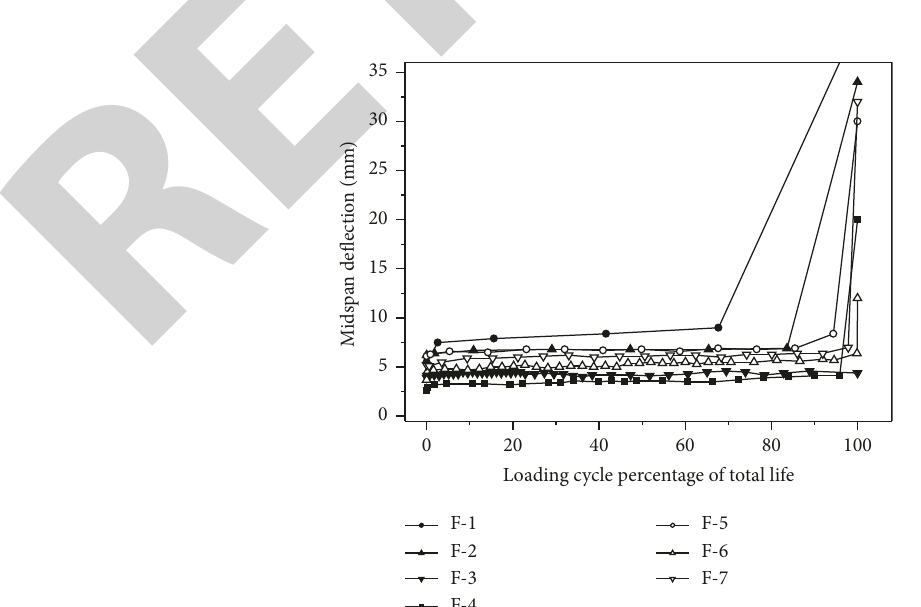
Figure 7: Crack distribution comparison for static and fatigue test girders. (a) S-1 girder crack distribution. (b) F-1 girder crack distribution.